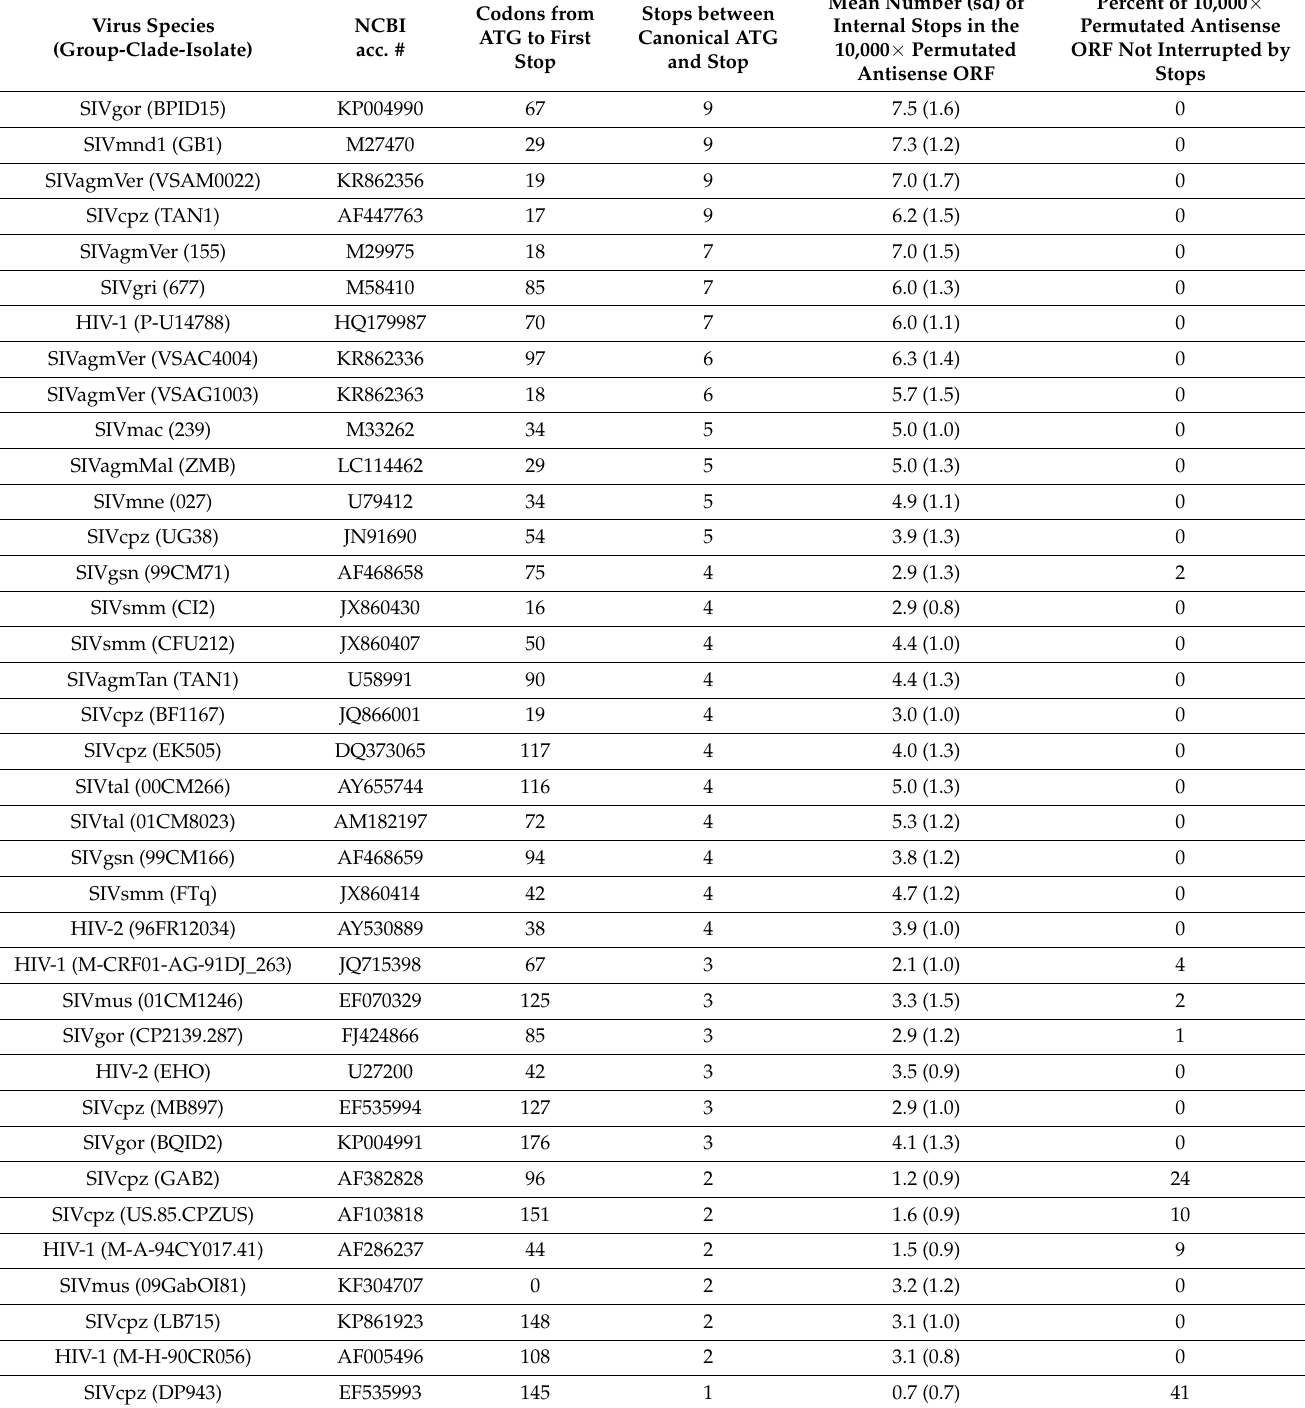
Table 1. Test of permutation of synonymous codons of env within the region of overlap with asp using 68 sequences from multiple human and non-human lentiviral genomes. Columns 1–4 report the name of the virus strain, NCBI accession number, the maximum length of the asp ORF within the region of overlap, and the number of internal stop codons in the asp ORF, respectively. For each sequence, we performed 10,000 permutations whereby we randomly swapped the order of all synonymous codons in the env ORF. We then determined the number of stop codons in the asp ORF that resulted from the codon swap in env [column 5; mean (sd)], and the percentage of the 10,000 permutations that yielded an asp ORF without internal stop codons (column